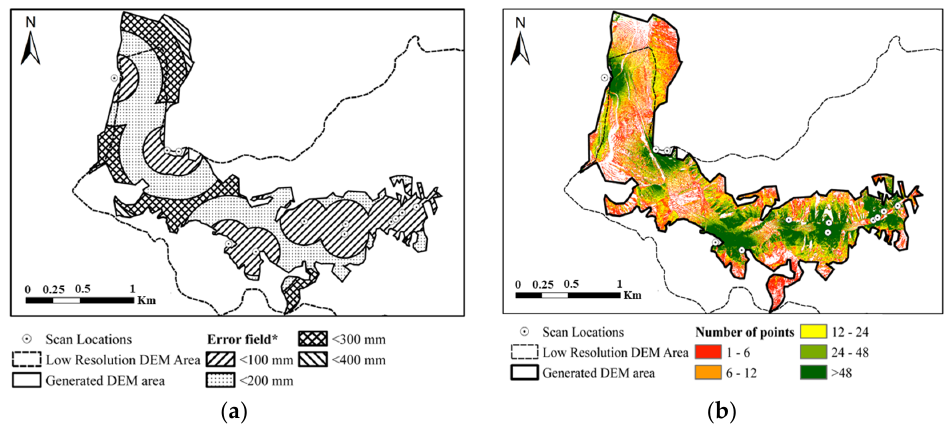
Figure 6. Point cloud data collection and processing in Jiangjia Gully area showing ( a ) data acquisition points with error fields and ( b ) point cloud data obtained from scanning, with density of points shown.